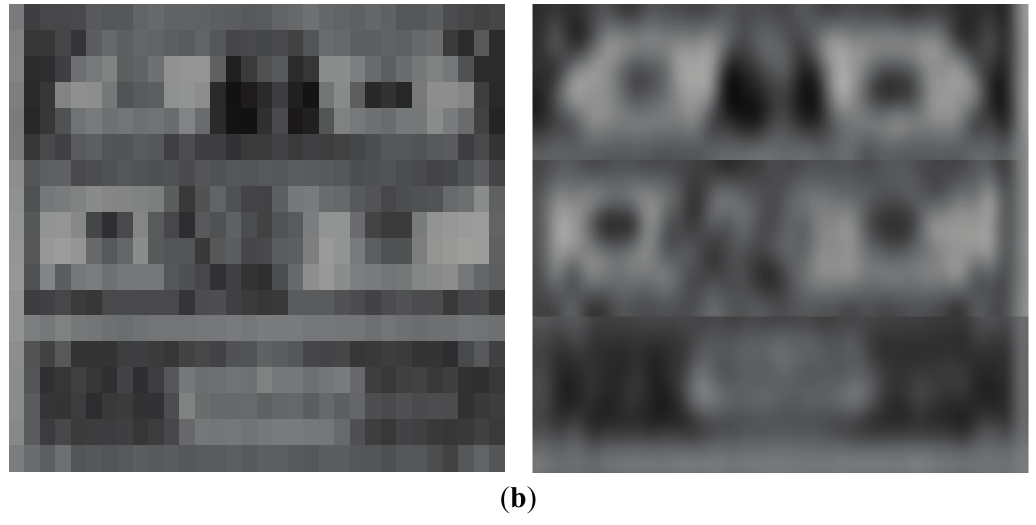
Figure 3. Examples of sub-sampled images: ( a ) original ROI areas of the banknote; ( b ) sub-sampled